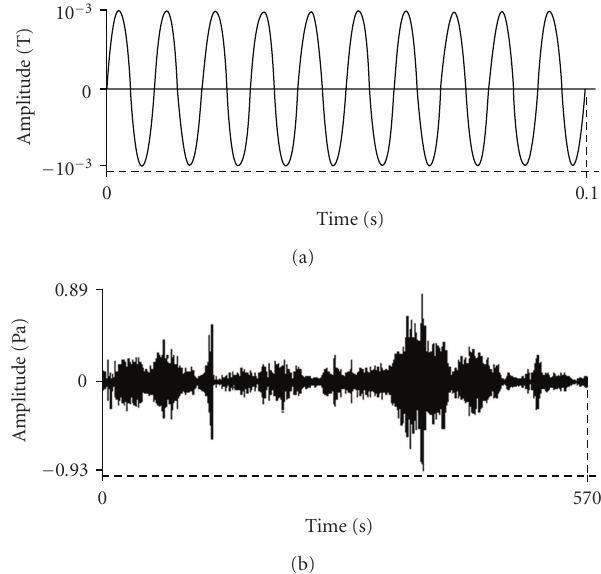
Figure 1: The ELF was produced by alternating-current electro- magnets. The waveform was sinusoidal with a frequency of 100 Hz; the amplitude was adjusted according to the distance between the polar expansions (a). The TAMMEF was produced by supplying the electromagnets with an outgoing current from an amplifier driven by a signal from recorded music (b). The signal shown in (b) contains extremely variable frequencies, amplitudes, and waveforms, and was generated by playing Rachmaninov’s Piano Concerto number 2 in C minor Op.18 for piano and orchestra, the same used in the experiment. The oscillations are close together because the predominant frequencies are in the thousands of